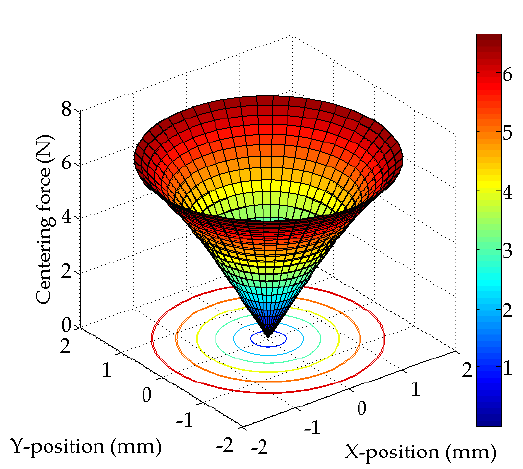
Figure 4. Finite element analysis (FEA) results of centering force (detent force).